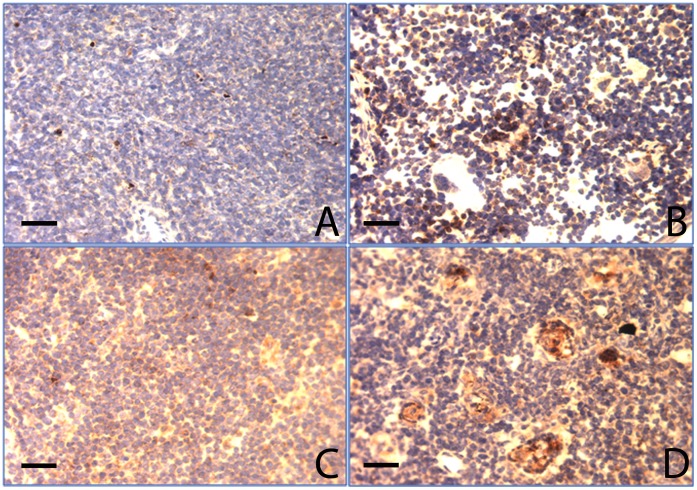
Analysis of apoptosis in thymus and spleen using Oligo-ApopTaq assay (×20).Panels A & B are OCTN2+/+ and OCTN2−/− mouse spleen sections and panels C & D are OCTN2+/+ and OCTN2−/− mouse thymus sections respectively. (Bar represents 50 µm).